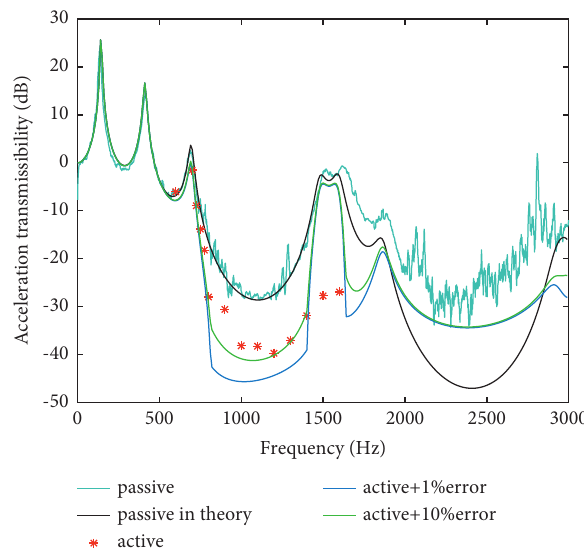
Figure 28: Acceleration transmissibility when the left acceleration is 0 . 5m/s 2